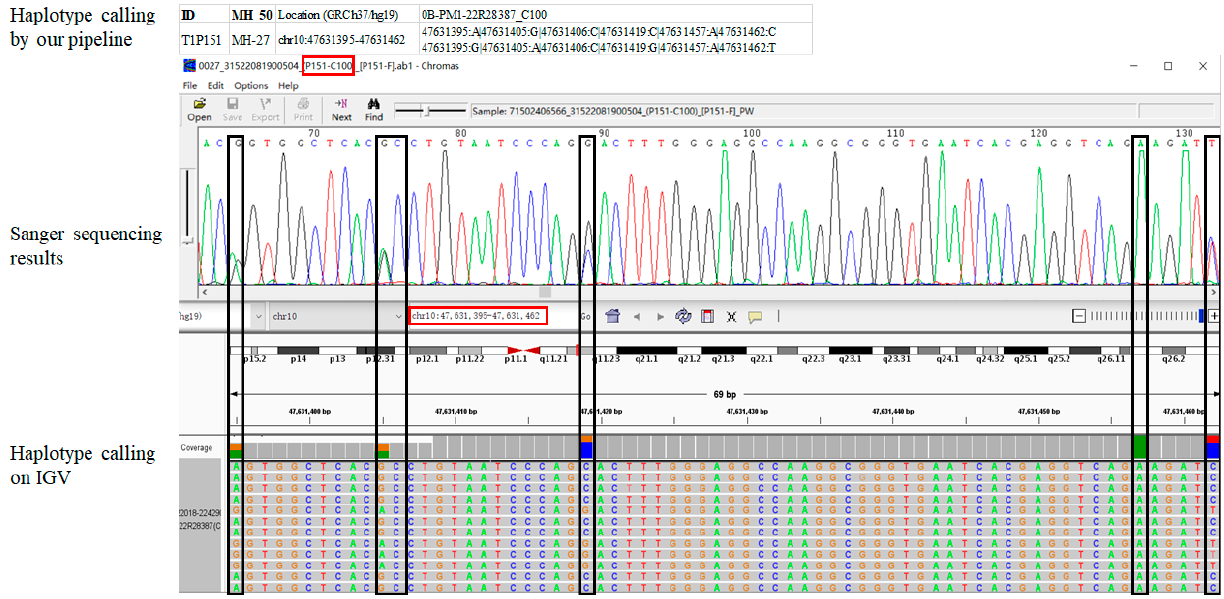
Figure 3. An example of three analysis methods for MH-27 in sample C100. The entire figure shows the genotypes obtained by our pipeline, Sanger sequencing, and Integrative Genomics Viewer (IGV) from top to bottom. The black boxes indicate the target SNPs. The two red boxes represent “MH ID- Sample ID” and “Location (GRCh37/hg19)”, respectively. The screenshot only displays the physical location and length of the target MH.